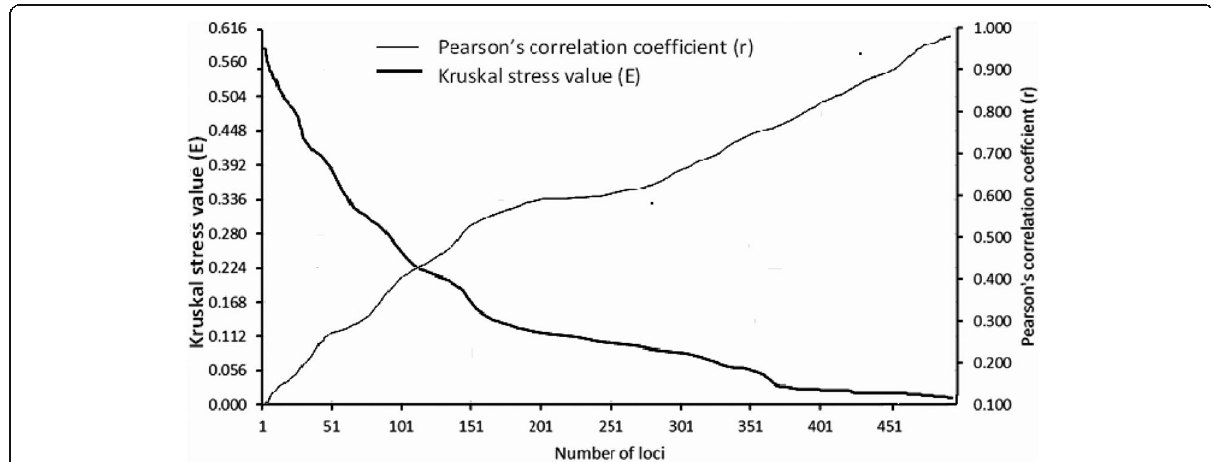
Fig. 5 Bootstrap analysis of 24 TRAP marker combinations based on Nei ’ s genetic